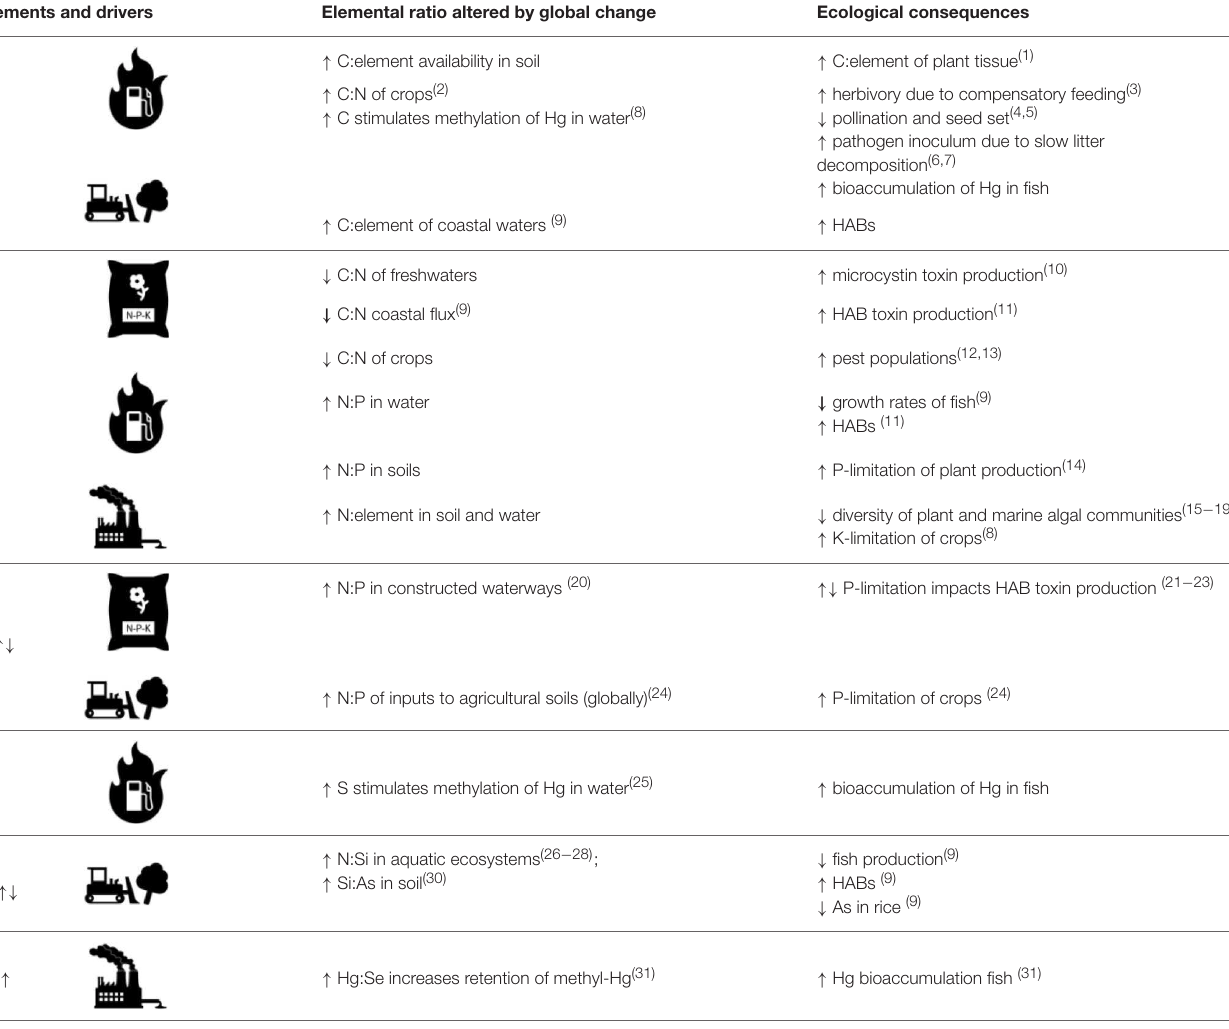
TABLE 2 | Human drivers of altered elemental ratios in the environment and ecological consequences relevant to human health. Elements and